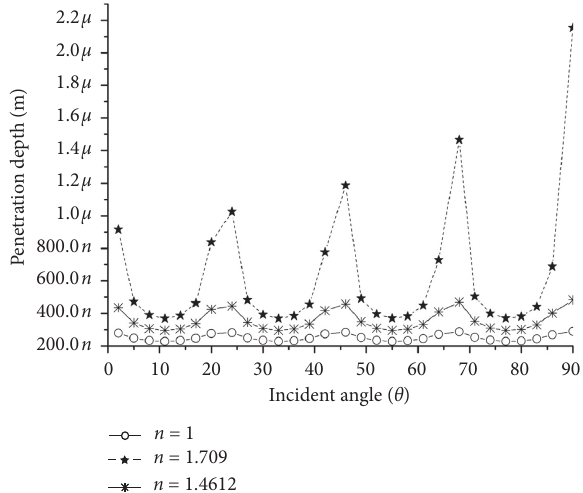
Figure 4: Evanescent wave depth penetration for different refractive indices of